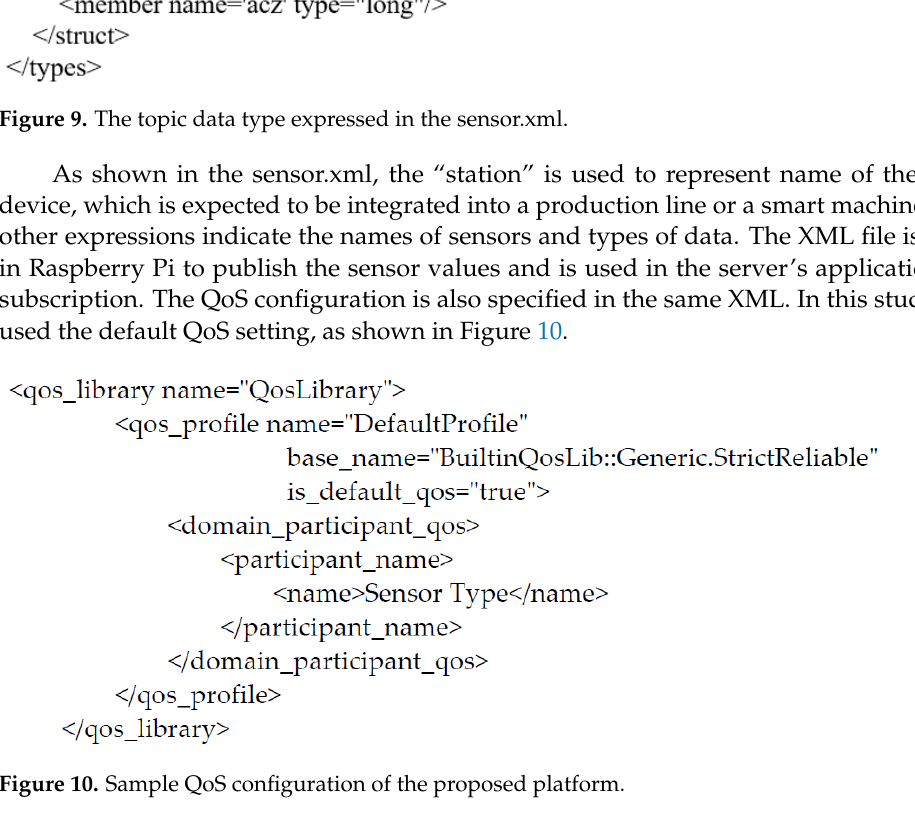
Figure 9. The topic data type expressed in the sensor.xml.